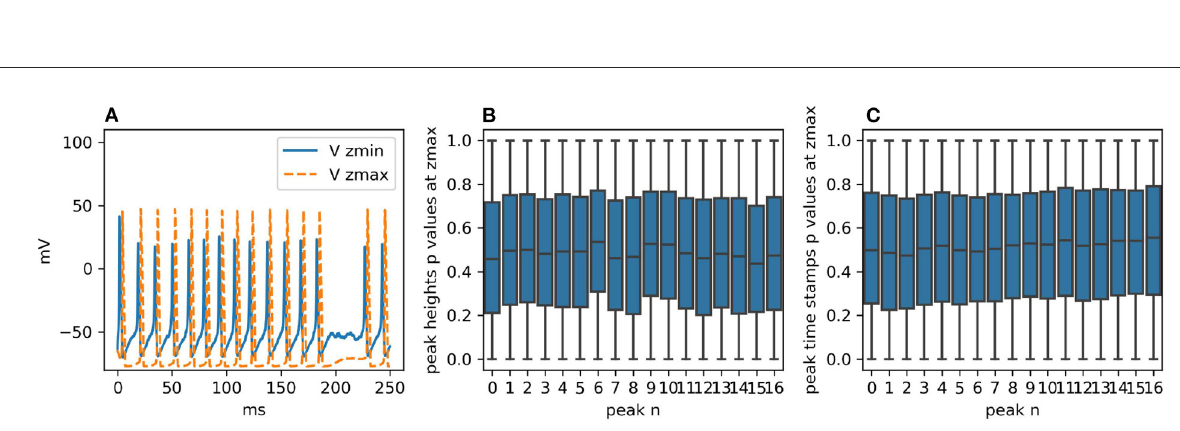
FIGURE5 (A) Voltage traces at z min and z max for one realization of the simulation with STEPS 4. Failed spikes can occur with single-channel sodium and potassium conductances of 20 pS, as shown, but are eliminated with 4pS. (B) With single-channel conductance of 4pS, boxplots for each peak height at z max of the p -values generated by dividing the two samples in 100 batches of 100 runs and then comparing them with the CVM test. As expected, the distributions are uniform. (C) The same analysis for the peak heights. Their intrinsic discretization does not affect the p